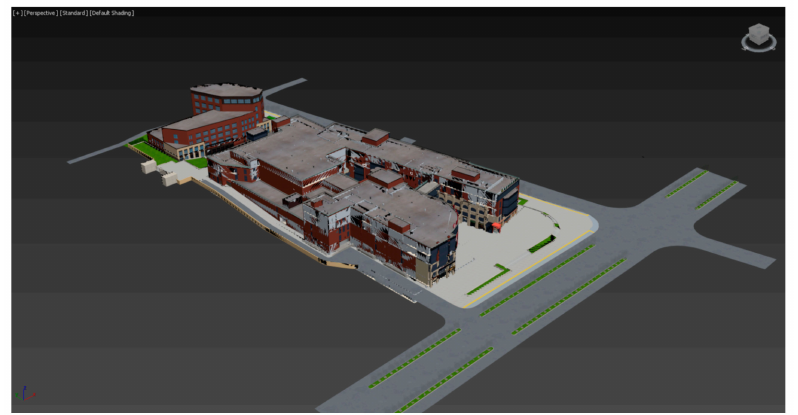
Figure 11. BIM Data